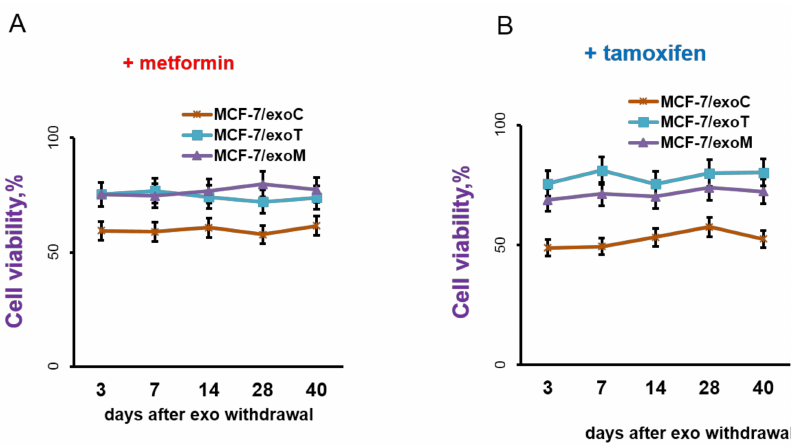
Figure 6. Exosome withdrawal and cell response to metformin and tamoxifen. MCF-7 cells after 14 days’ treatment by exosomes from MCF-7, MCF-7/T or MCF-7/M cells (named as MCF-7/exoC, MCF-7/exoT and MCF-7/exoM cells, respectively) were transferred to standard exosome-free medium and cell sensitivity to metformin ( A ) and tamoxifen ( B ) was regularly measured within 40 days of